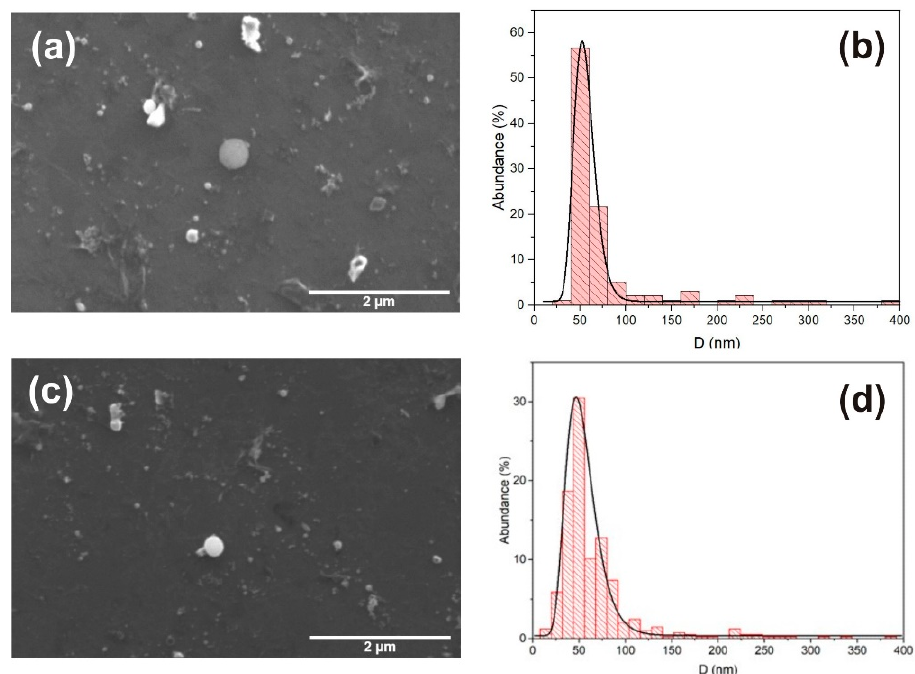
Figure 2. SEM micrograph of ( a ) pure ZnO NP with ( b ) corresponding size-distribution with maxi- mum at 53 nm. SEM micrograph of ( c ) Ag-doped ZnO NP with ( d ) corresponding size-distribution with maximum at 47 nm.